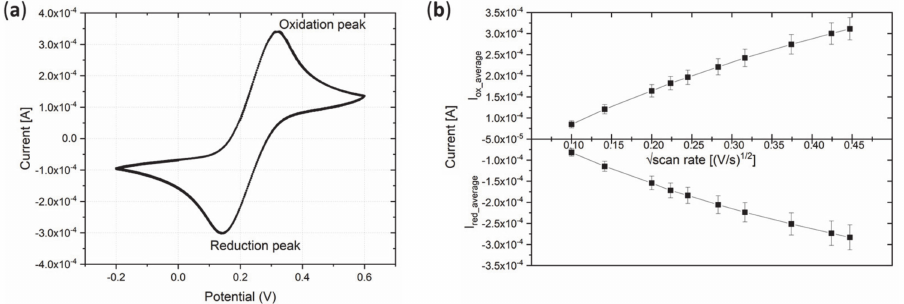
Figure 1. Cyclic voltammetry of a Au electrode on polystyrene (PS) foil in ferro-ferricyanide solution. ( a ) Exemplary cyclic voltammogram. ( b ) Square root of the scan rate vs. maximum absolute values of reduction and oxidation currents ( n = 6). n = number of analyzed samples.